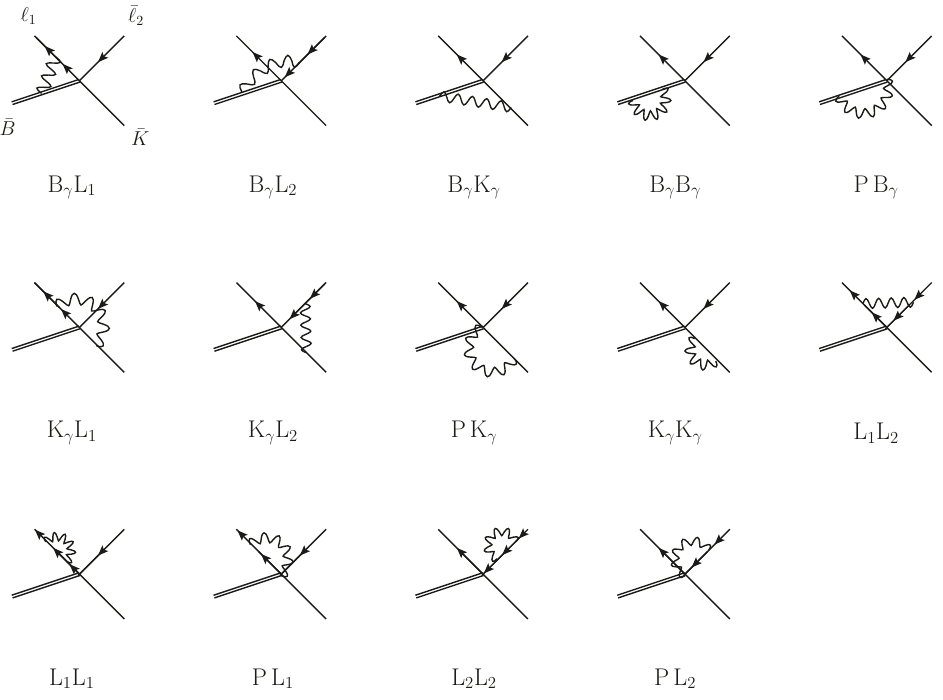
Figure 3 . O ( e 2 ) -graphs with nomenclature adapted for tracking the cancellation of